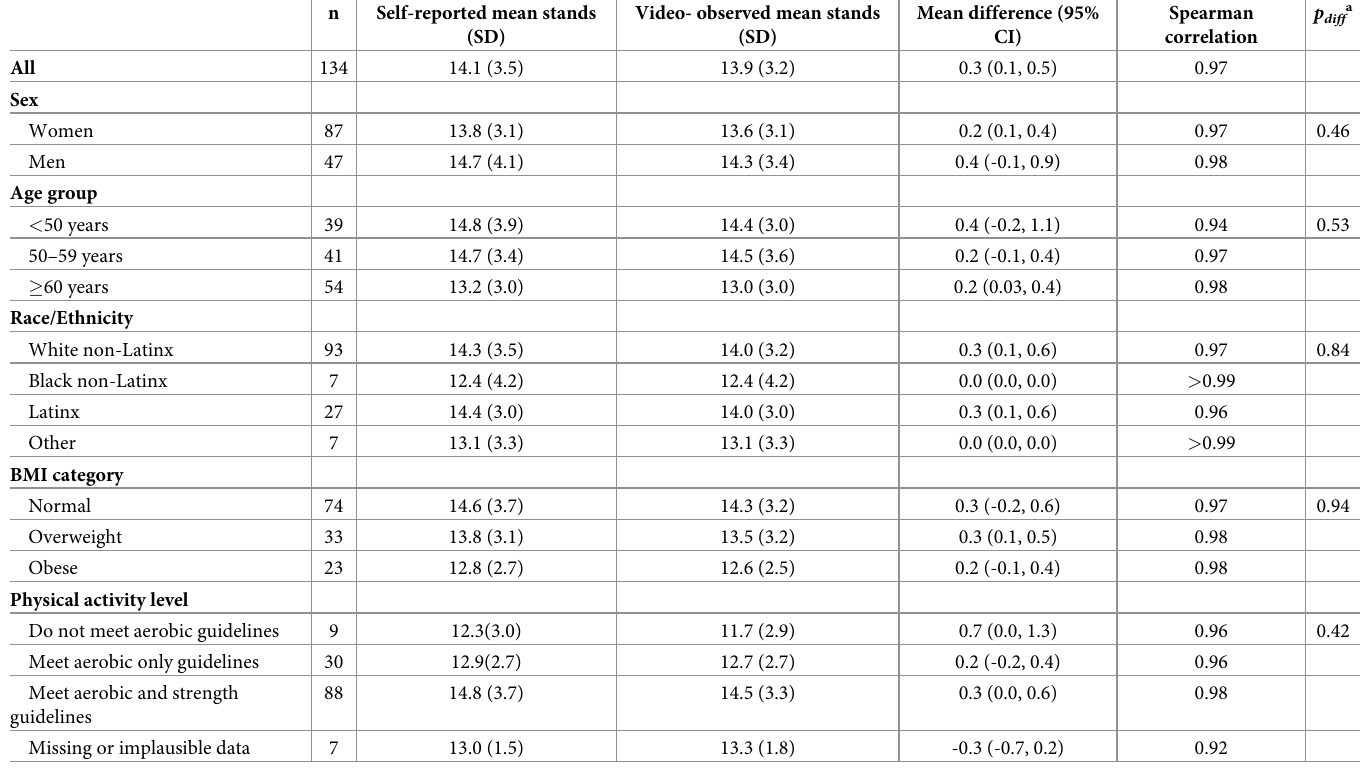
Table 3. Self-reported and video-observed number of stands: Means, mean differences, and spearman correlation coefficients by demographic and behavioral characteristics. n Self-reported mean stands